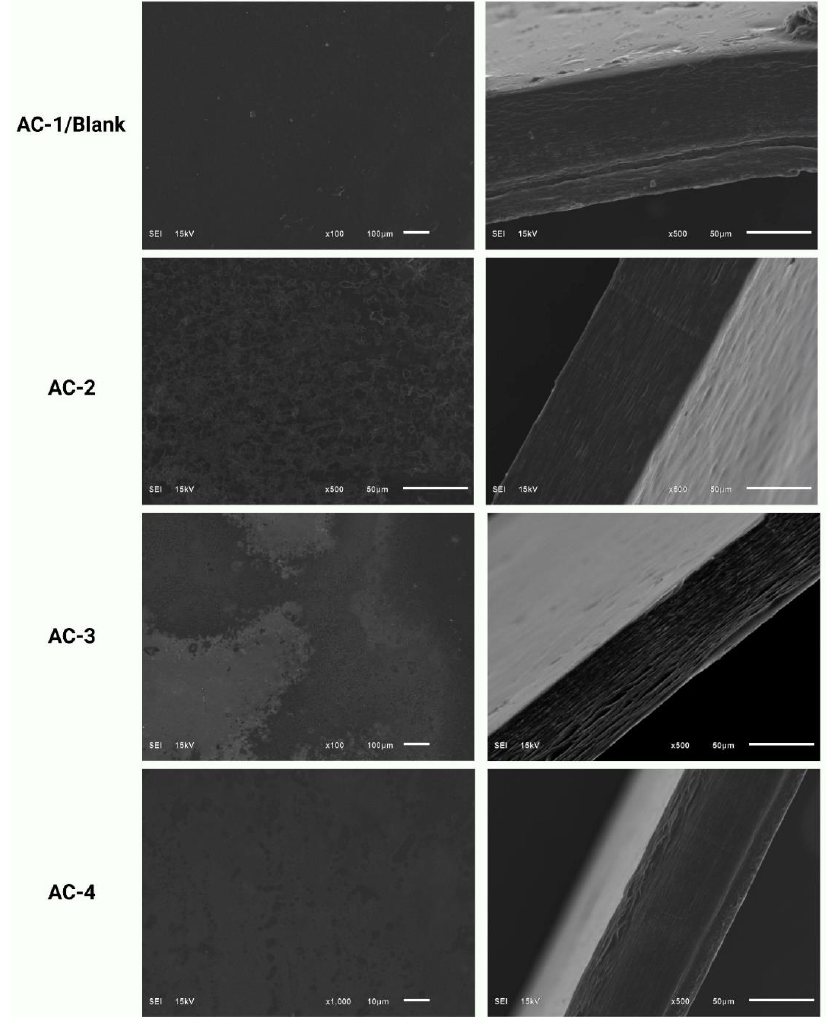
Figure 2. Scanning Electron Microscopy of SA–AG hydrogel-based edible films; AC-1/Control, AC-2 contains 15 μL of CEO, AC-3 contains 20 μL of CEO, and AC-4 contains 30 μL of CEO.